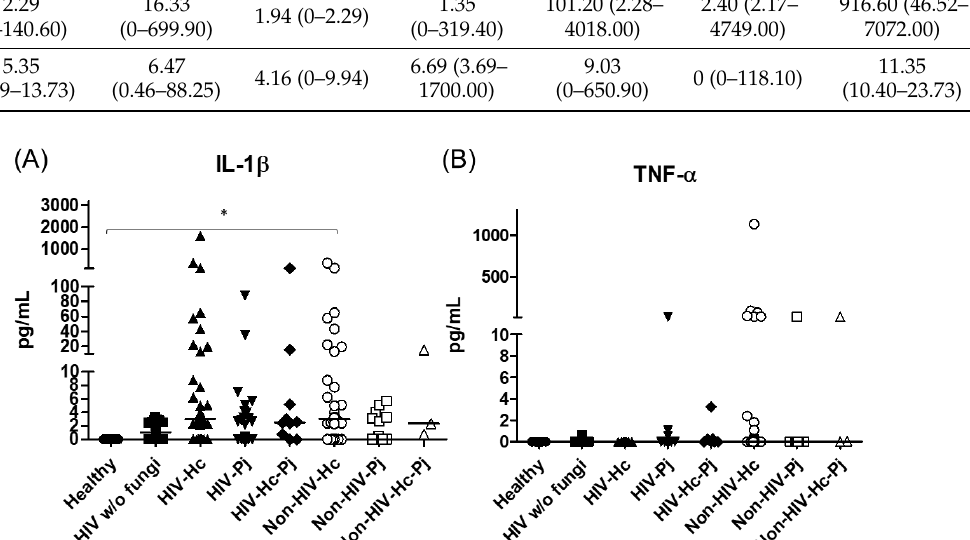
Figure 2. Surfactant proteins determination. Pulmonary SP-A and SP-D were measured in the BAL samples of hospitalized patients, using ELISA; results were obtained in ng/mL. Median values are shown for ( A ) SP-A and ( B ) SP-D. * p < 0.05.